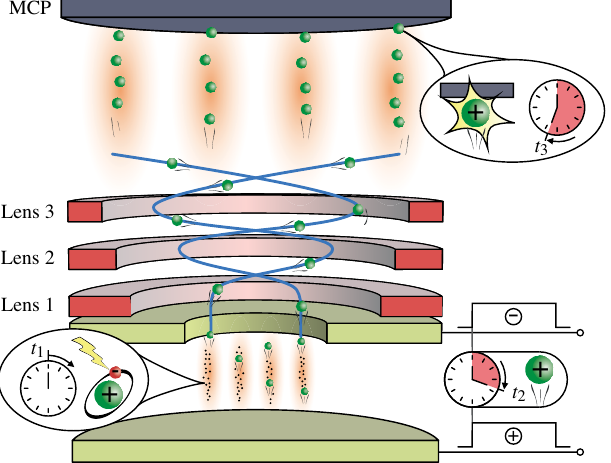
FIG. 1. Concept of the pulsed ion microscope. Neutral atoms in a quantum gas (shown in a 1D periodic potential) are converted into ions at time t ¼ t 1 via a suitable ionization process (e.g., near-threshold photoionization). After a variable wait time, an extraction field is pulsed on ( t ¼ t 2 ), and the ions are imaged onto a spatially resolving detector by means of an ion microscope consisting of three electrostatic lenses ( t ¼ t 3 ). The high time resolution of the multichannel plate detector (MCP) allows for the study of dynamical processes (e.g., in strongly interacting many- body systems) and 3D imaging via the time-of-flight information. The versatile nature of the concept enables the study of ground- state ensembles, Rydberg systems, and ionic impurities.